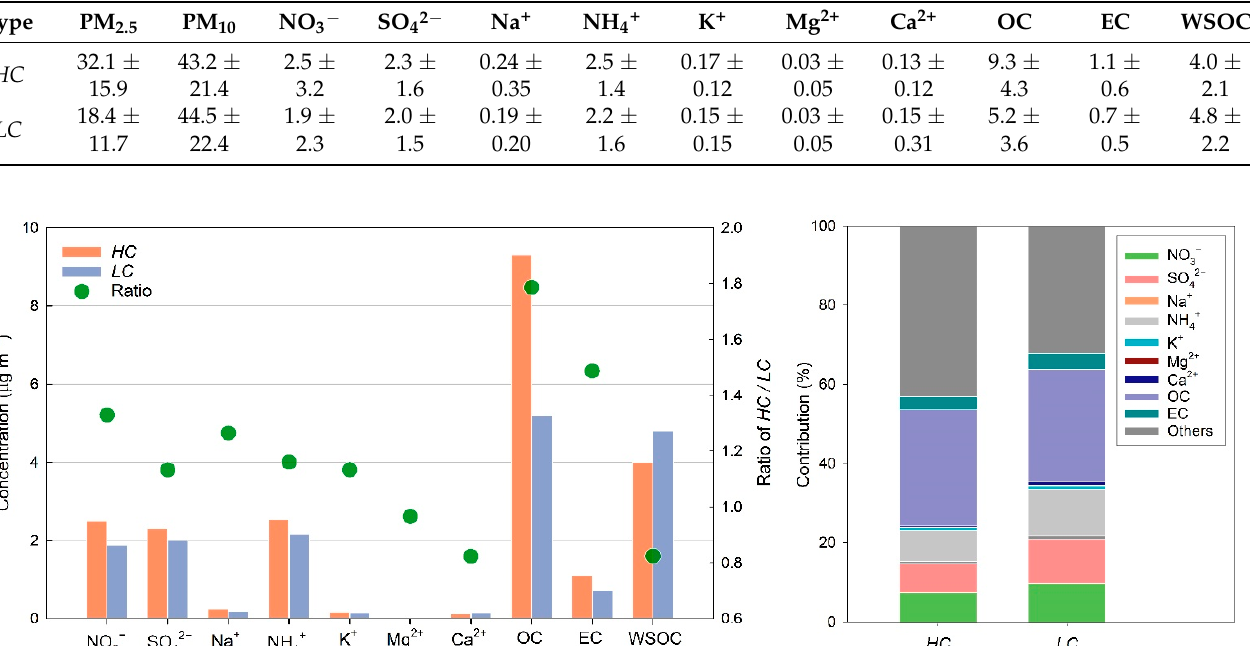
Table 3. Average PM 2.5 concentrations of HC , LC , and other samples and their major chemical components. Type PM 2.5 18.4 ± 11.7 44.5 ± 22.4 1.9 ± 2.3 2.0 ± 1.5 0.19 ± 0.20 2.2 ± 1.6 0.15 ± 0.15 0.03 ± .05 0.15 ± 0.31 5.2 ± 3.6 0.7 ± 0.5 4.8 ± 2.2